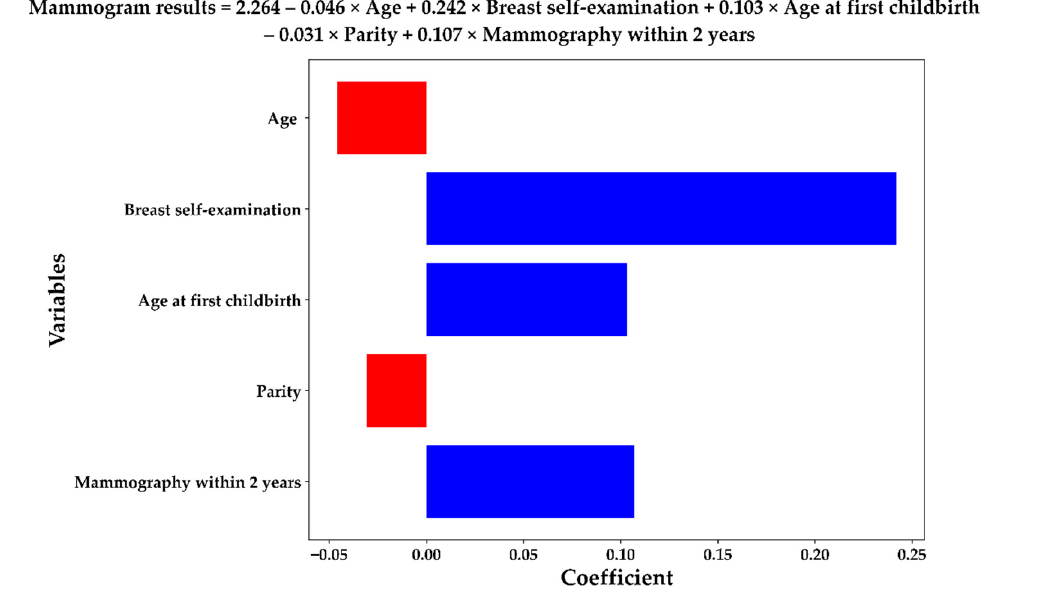
Figure 5. Lasso equation with the selected five important variables.